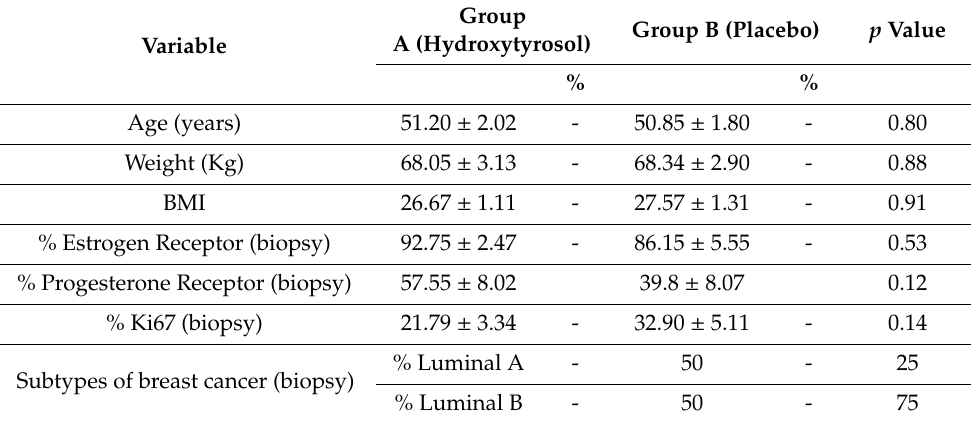
Table 1. Clinical variables of the experimental groups at the beginning of the study.